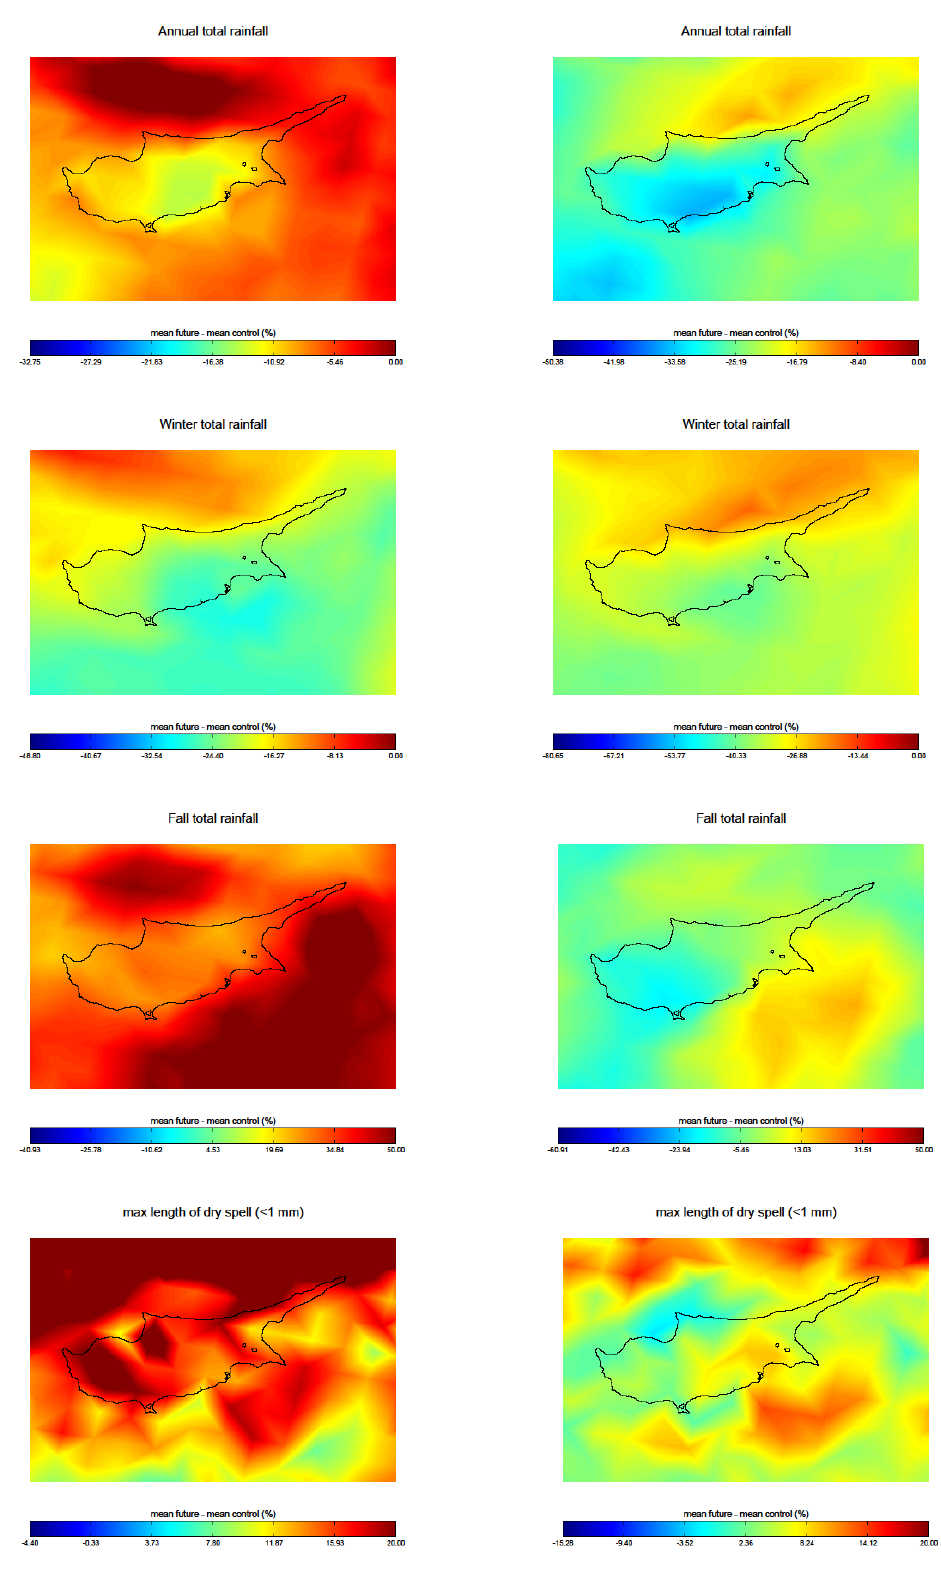
Fig. 4. Percentage differences between the 2021–2050 future period (left), the 2071–2100 future period (right) and the control run period for the annual total rainfall, winter total rainfall, autumn total rainfall and the duration of the period with precipitation under 1mm.